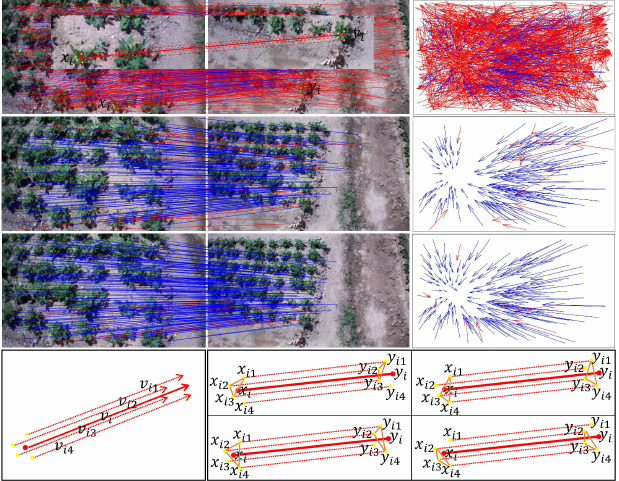
Figure 4. Comparison I of LPM and TAT: eliminate false matching point pairs. SIFT algorithm initial matching result ( row 1, left ); LPM algorithm matching result ( row 2, left ); TAT algorithm matching result ( row 2, left ); matching result vector cluster map ( row 1 to row 3, right ); schematic diagram of displacement vector of LPM algorithm ( row 4, left ); and schematic diagram of affine model constraint of TAT algorithm ( row 4, right